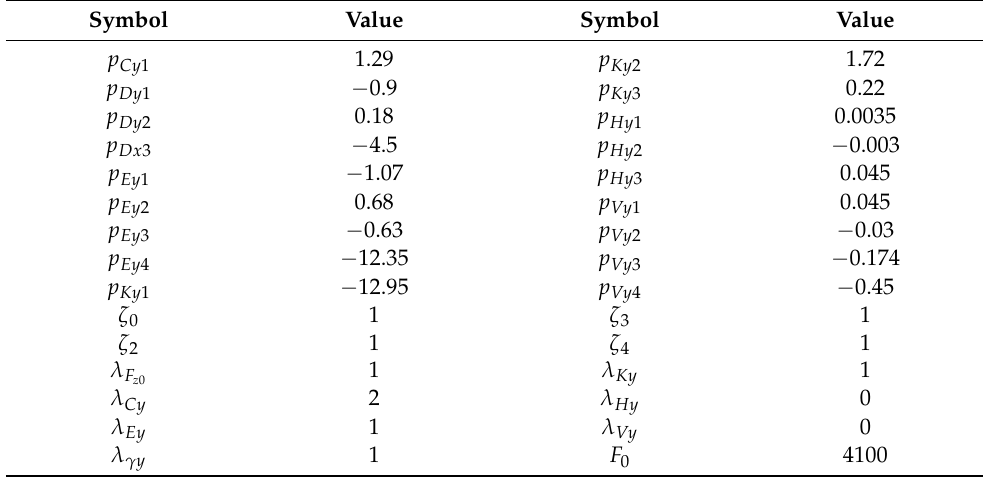
Table 4. The key parameters used in the tire